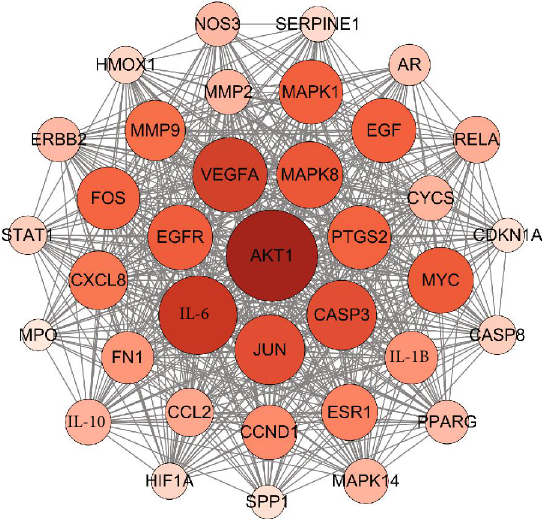
Figure 5: Key targets of HLJDD against